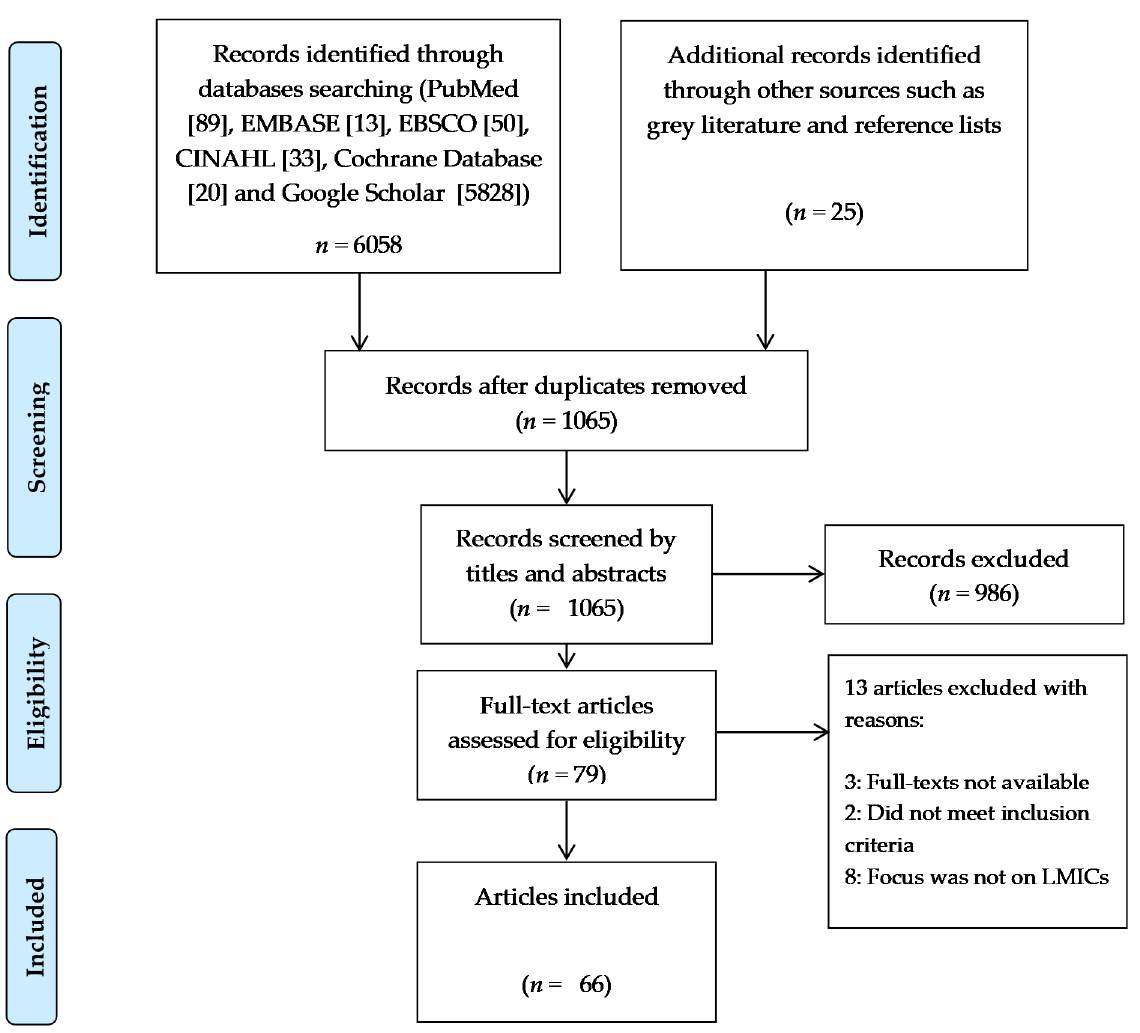
Figure 1. PRISMA Flow Diagram.